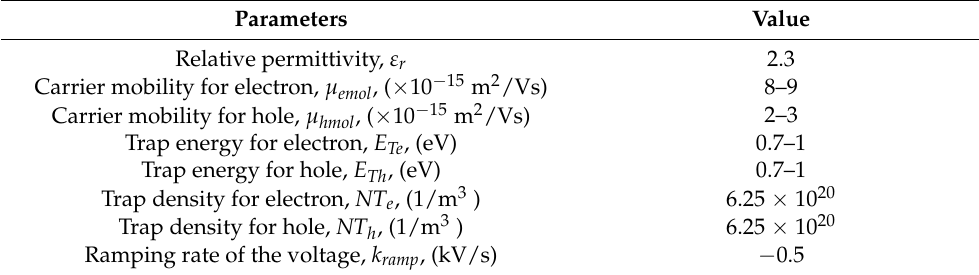
Table 1. The values of the parameters used in BCT simulation